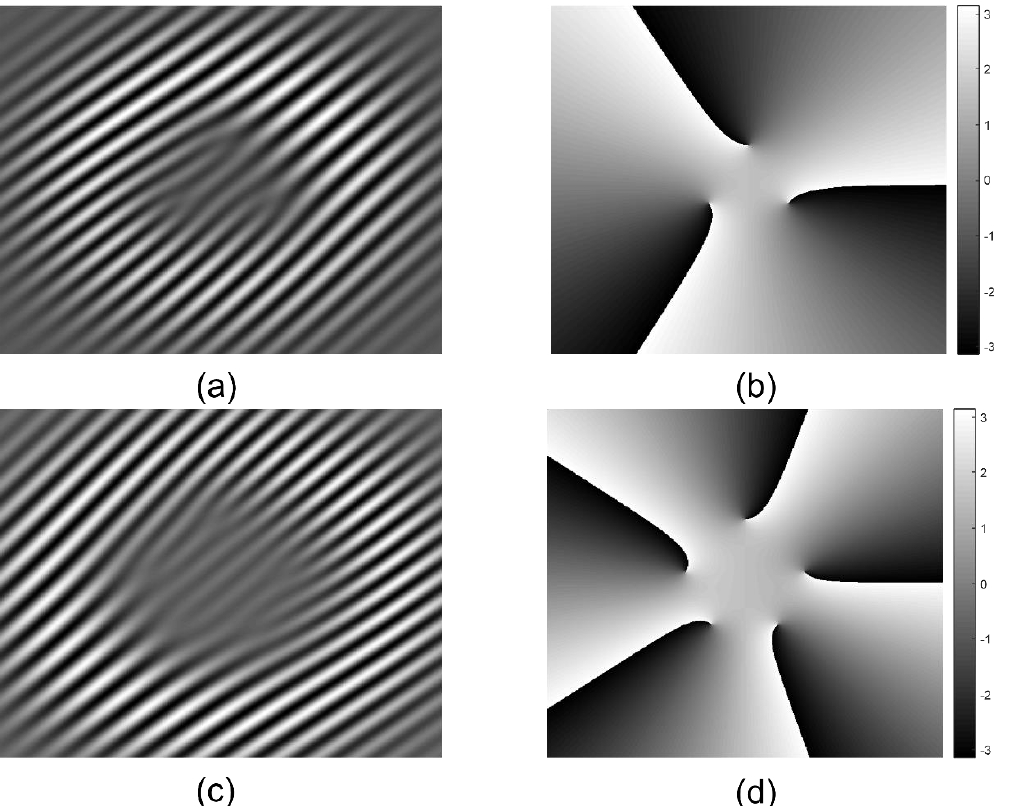
Figure 3. The separated optical vortices with the addition of the plane wave, ( a ) and ( c ); the phase map for the separated optical vortices, ( b ) and ( d ). Cases ( a ) and ( b ) were generated for m = +3; ( c ) and ( d ) were generated for m = −5. The plane wave slope direction was the same in all cases.